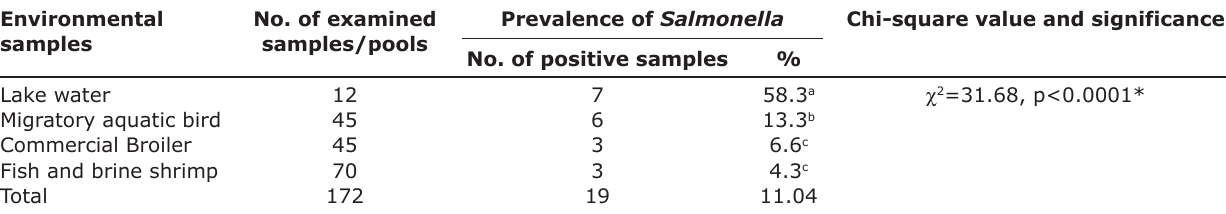
Table-3: Prevalence of Salmonella in different sources collected from Lake Qarun. Environmental samples